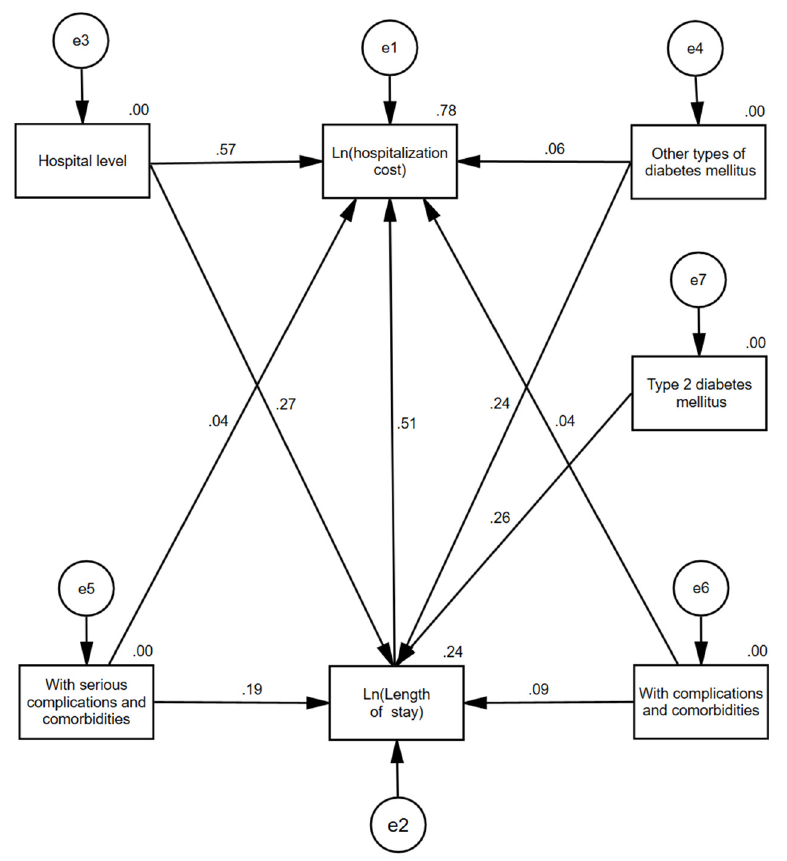
Figure 1. Path diagram of factors influencing hospitalization costs in diabetic patients. Table 4. Effect decomposition table of influencing factors of hospitalization cost of diabetic